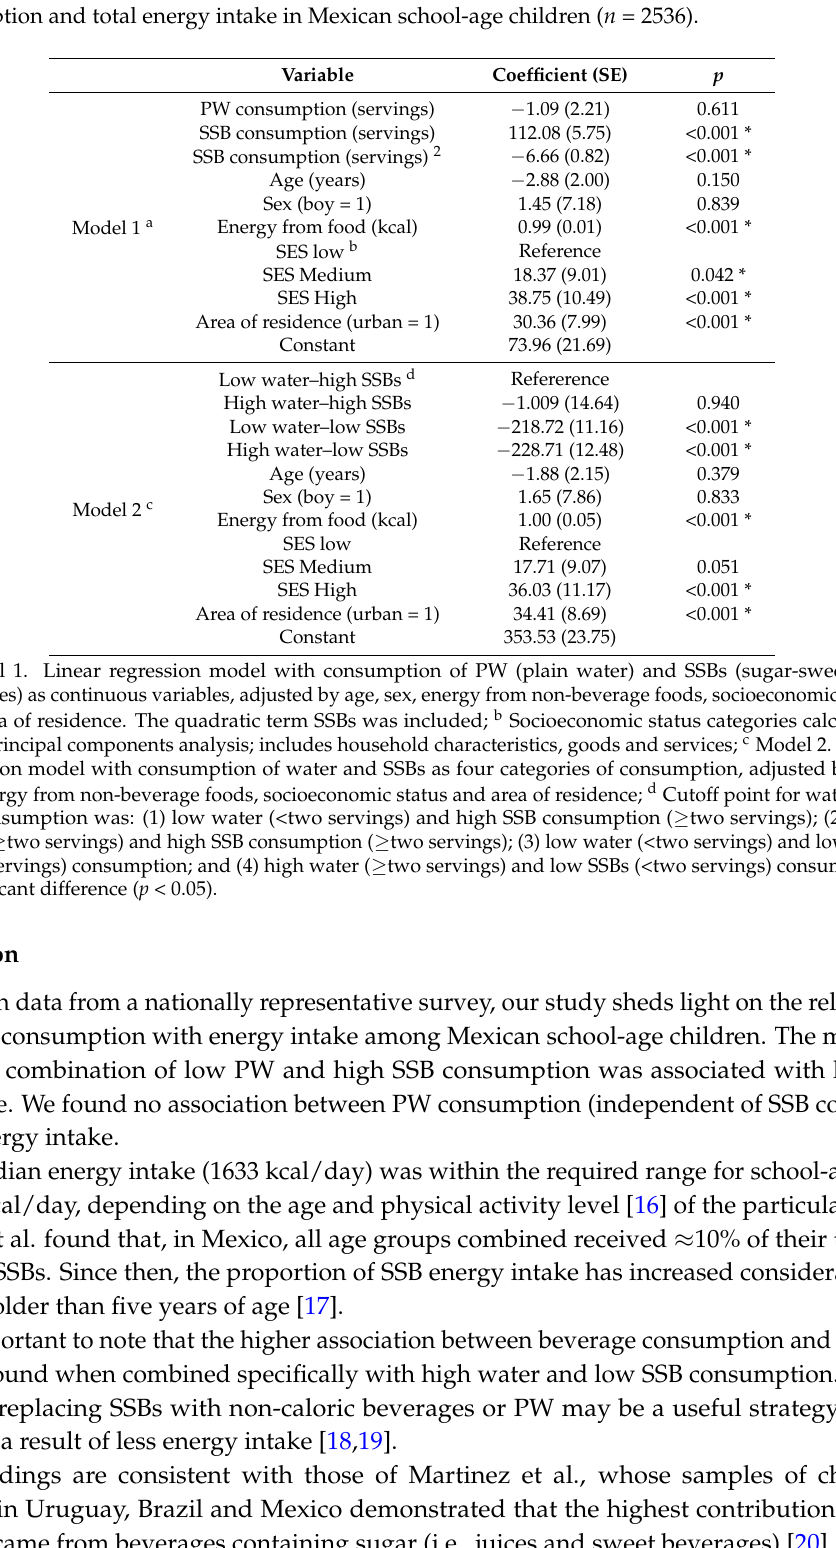
Table 5. Multivariate linear regression analyses showing the association between beverage consumption and total energy intake in Mexican school-age children ( n =